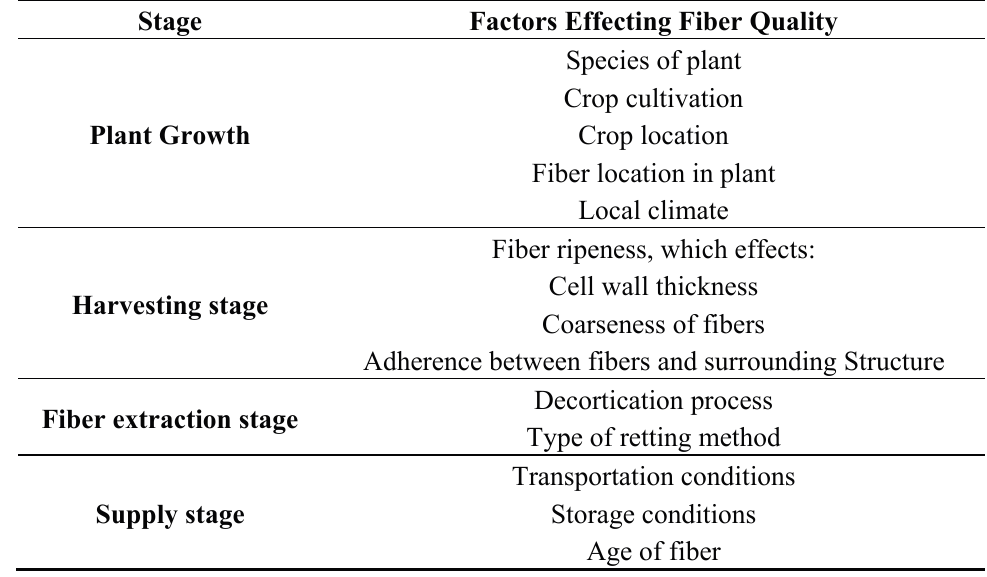
Table 4. Factors effecting fiber quality at various stages of natural fiber production. Reprinted with permission from Elsevier, 2012 [9].